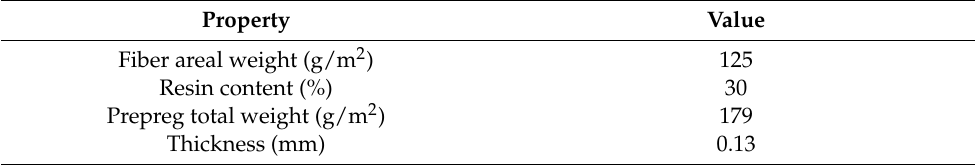
Table 1. Properties of the UD carbon fiber/epoxy